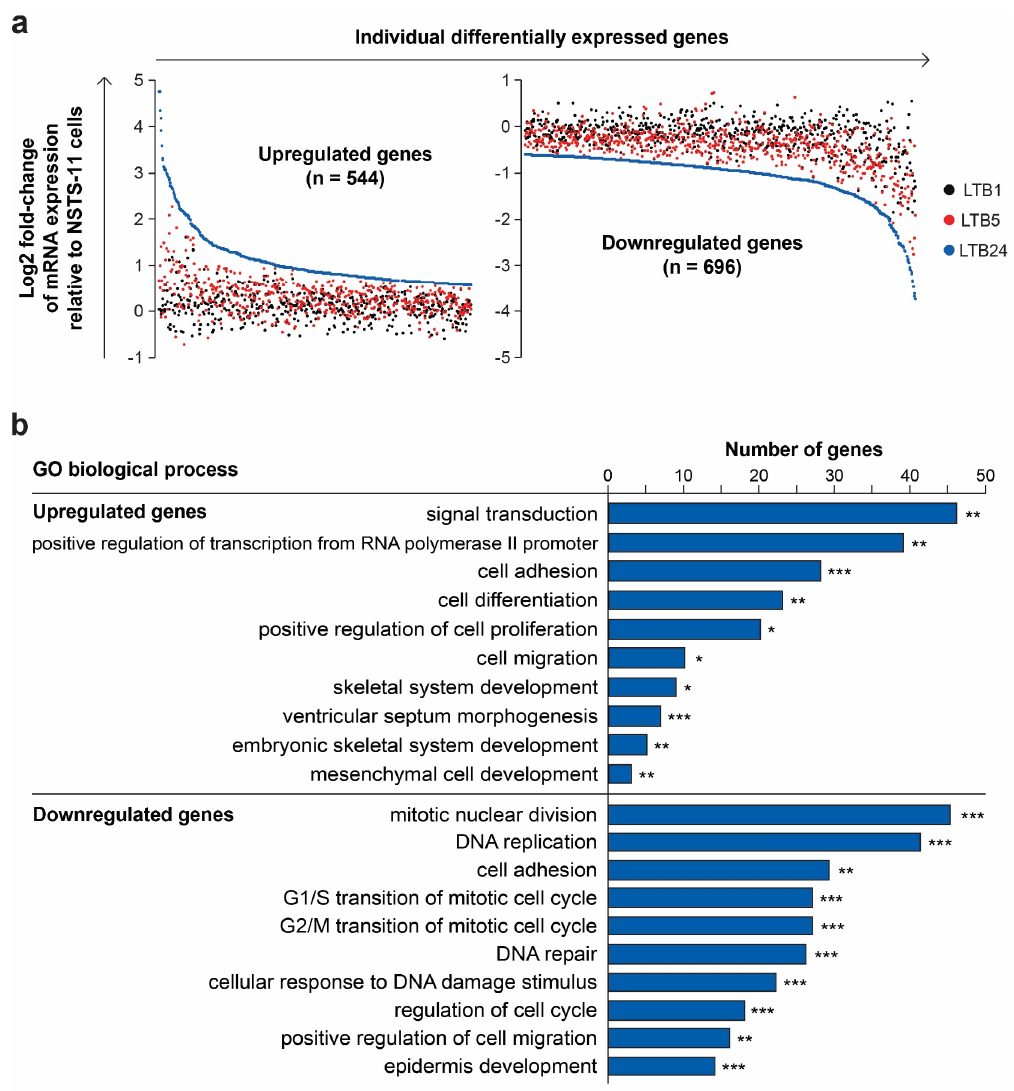
Figure 5. Analysis of the di ff erentially expressed genes. ( a ) Expression levels of di ff erentially expressed genes identified by their upward (upregulated genes; left plot) or downward (downregulated genes; right plot) trend of expression over passages in vivo; ( b ) Gene ontology (GO) analysis of biological processes. The DAVID annotation tool with the GOTERM_BP_DIRECT database was used. Modified Fisher’s exact test, * p < 0.05, ** p < 0.01, and *** p <